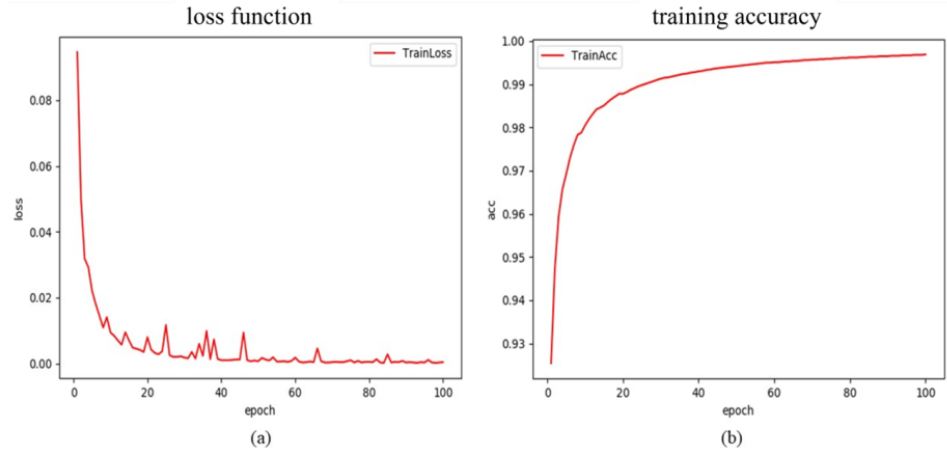
Figure 5. Curves of ( a ) loss and ( b ) accuracy.